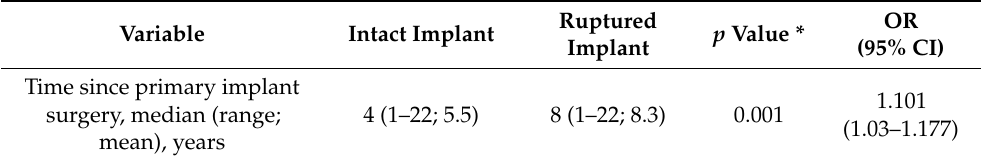
Table 1. Time since primary breast implant surgery.